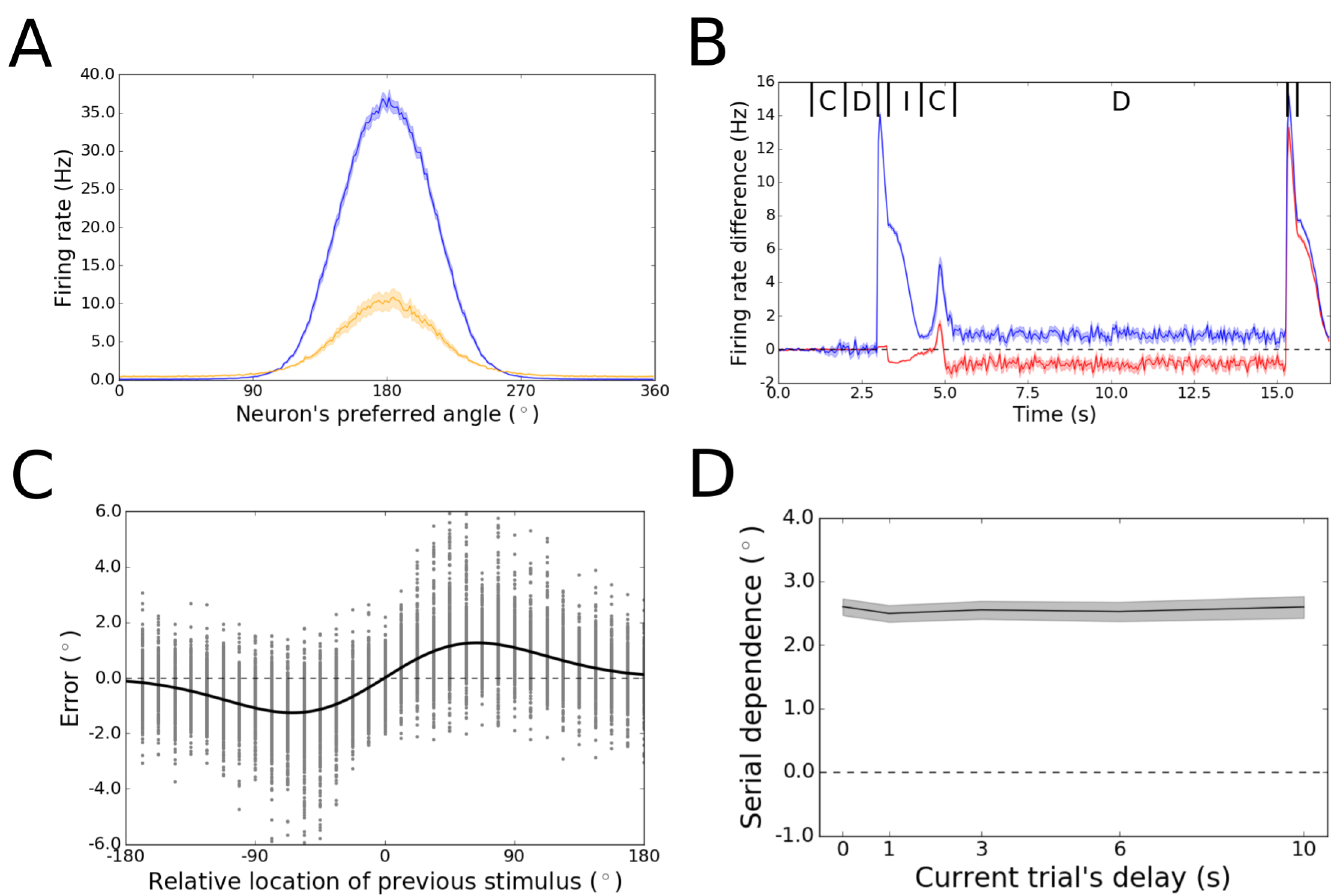
Fig 2. Results for Model 2. (A) Consistent with physiological data from monkeys [18], the amplitudeof the activity bump duringthe ITI (yellow)is approximately one-quarter the size of the bump in the middleof the workingmemory delay (blue) in the activity leak model. Shadingindicatesthe standard error of the mean for a singlerepresentative trial. (B) Differencebetweenthe activity patterns in the activity leak model and the originalbump attractor model for two exampleneurons(blue and red). Shown are the firing rates for these two neuronsin the activity leak model subtracted by their firing rates in the originalmodel. A singlepair of trials is displayed, just like in Fig 1B. In this case, the first stimulus was presented at 180˚ and the second at 112.5˚. The two neuronsshown have preferredangles of 146.25˚ (blue) and 78.75˚ (red), which places them on oppositeflanks of the bump formed for the second stimulus in this pair. The two models perform equivalentlyfor the cue and delay periods (labeledC and D) of the first trial. However, activity duringthe first response and subsequent ITI (labeledI) for the neuronin blue is much higherin Model 2 than in Model 1, becausethe bump from the first trial persists duringthese periods only in Model 2. (In additionto being on a flank of the bump for the second stimulus in this pair, the neuronin blue is also on a flank of the bump for the first stimulus at 180˚—seeFig 1B.) The residualactivity dissipatesnoticeablyduring the ITI, but is sufficient to bias activity duringthe cue periodof the second trial, such that the firing rates for the two neuronsare shifted away from their rates in Model 1 by a few Hz in either direction. The directionality of this shift in firing rates indicatesthat the bump on the second trial has shifted toward the previous stimulus. (C) Tuning of serial dependenceacross angular differences betweenconsecutive stimuli. Raw errors are in gray, and the best fit of the DoG function is in black. Serial dependence with an amplitude consistentwith what is observedin humans is apparent.(D) Peak-to-peak of the DoG model across the workingmemory delay period. Shadingrepresents bootstrapped 95% confidenceintervals. Serial dependenceis non-zeroat all delays. The amplitudeof serial dependence is large at the moment of stimulus offset and does not change over time.